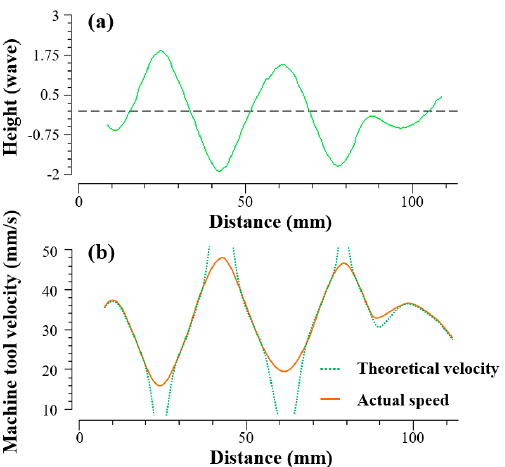
Figure 6. ( a ) Large gradient error to be processed. ( b ) Comparison of the ideal and actual speed of the machine tool.